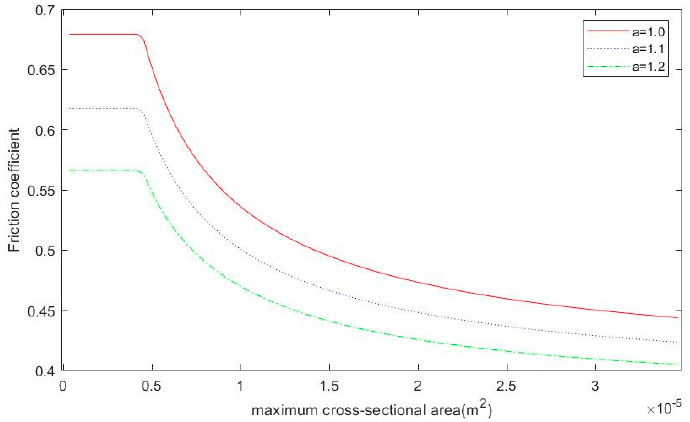
Figure 3. Friction coefficient versus maximum cross-sectional area.